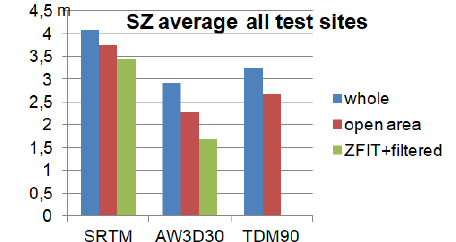
Figure 22. Average standard deviation of all test sites with test site Mountain for terrain inclination below 0.1